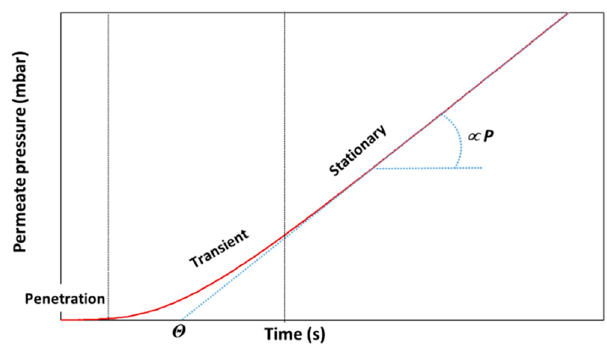
Figure 1. Typical output curve of a time lag measurement performed on a constant volume/pressure increase instrument in a regime where the permeate pressure is negligible compared to the feed pressure.